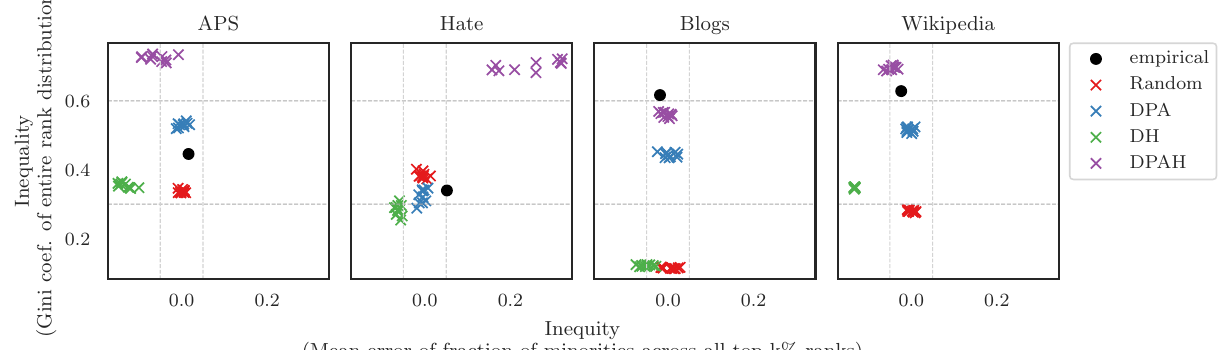
Figure 7. Global disparity in PageRank on empirical networks. Each column represents an empirical network. Citation/retweet networks (APS and Hate) and Hyper-link networks (Blogs and Wikipedia). Inequality and inequity are shown in the y- and x-axis, respectively. The disparity in ranking that we see in empirical networks are best explained as follows: (i) citation/retweet networks by preferential attachment PA, and (ii) hyper-link networks by preferential attachment and homophily